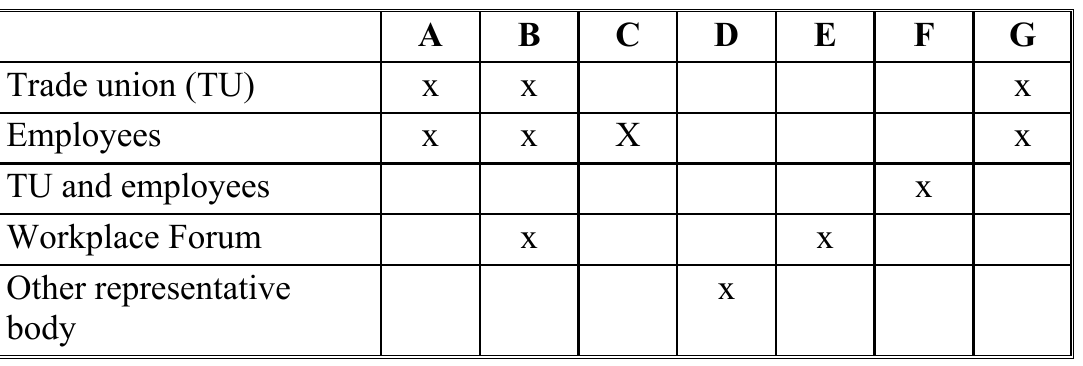
Management representatives(cid:146) responses